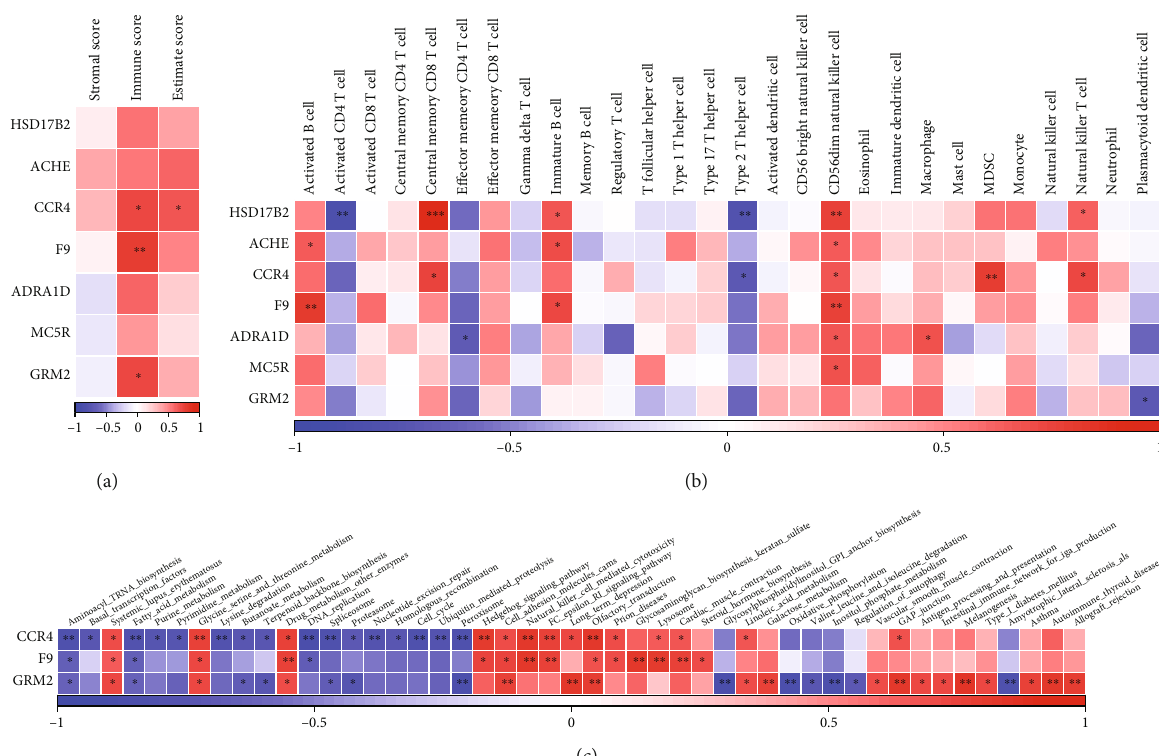
Figure 5: The correlation analysis between hub genes and immune. (a) The correlation analysis between 7 hub genes and immune scores. (b) The correlation analysis between 7 hub genes and 28 immune cells scores. (c) Heatmaps of potentially regulated pathways of 3 genes associated with immune.